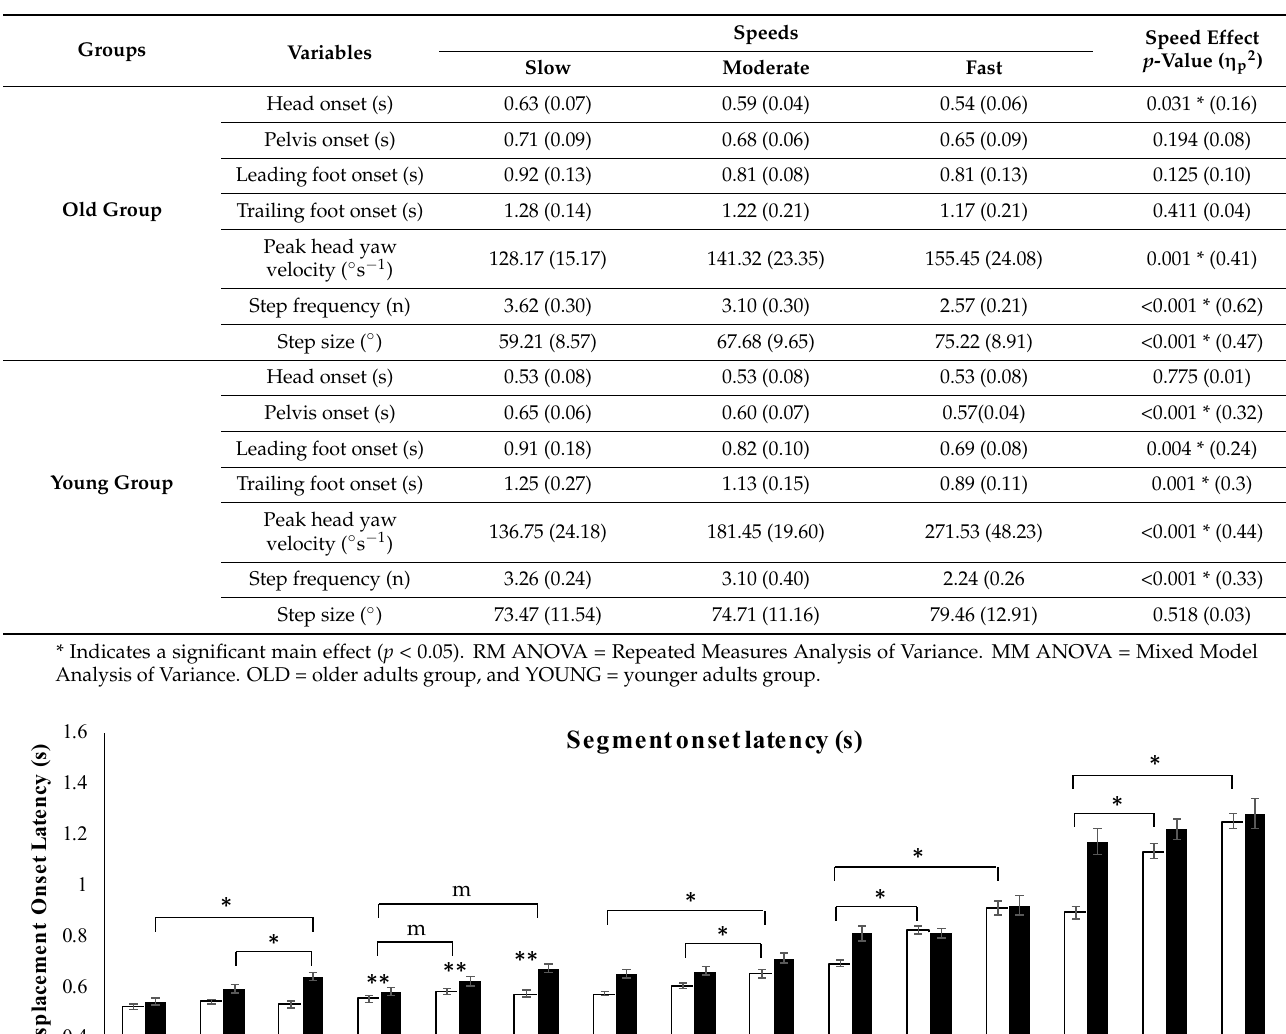
Table 2. RM ANOVA for variables that showed a significant interaction within MM ANOVA.